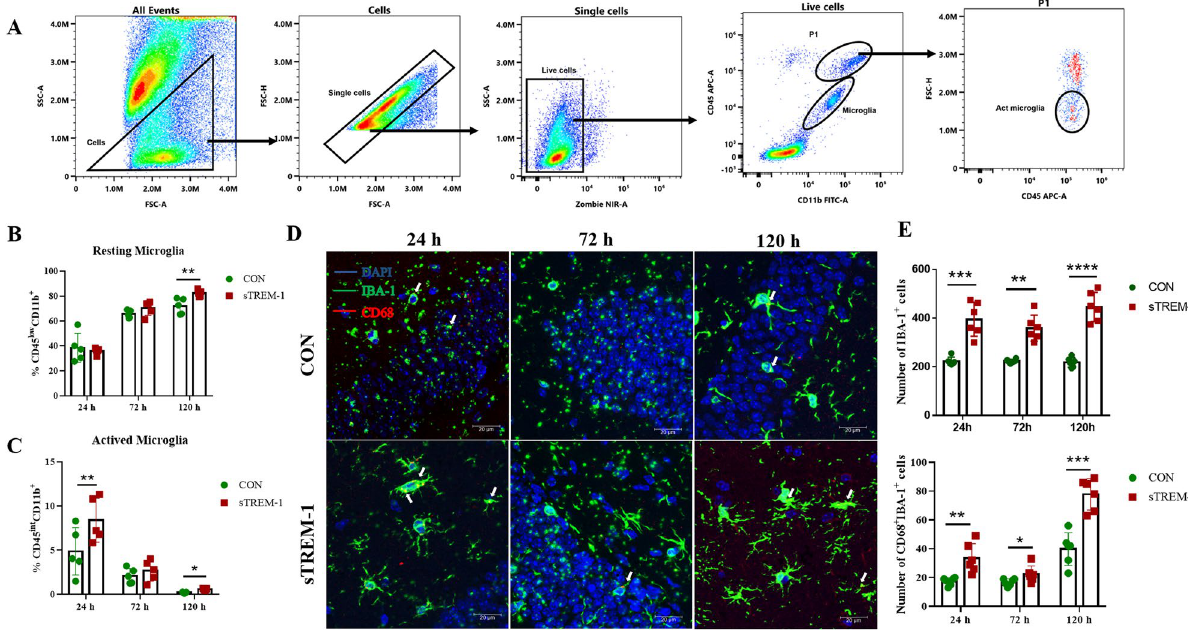
Figure 3. sTREM-1 promotes the activation of microglia in the hippocampus of mice. (A) The gating strategy of resting and activating microglia in the mouse hippocampus. (B) Quantitative analysis of the proportion of resting microglia in the hippocampus of per group mice, n = 5. (C) Quantitative analysis of the proportion of activated microglia in the hippocampus of each group mice, n = 4. (D) Representative image of IBA-1 and CD68 immunofluorescence double staining of the hippocampus in per group mice, where the white arrows indicated CD68 + IBA-1 + cells, scale bar is 200 μm. (E) Quantitative analysis of IBA-1 + , IBA-1 and CD68 double-positive cells, n = 6; Data are presented as means ± SEM of at least three separate experiments, * P < 0.05, ** P < 0.01, *** P < 0.001, **** P <